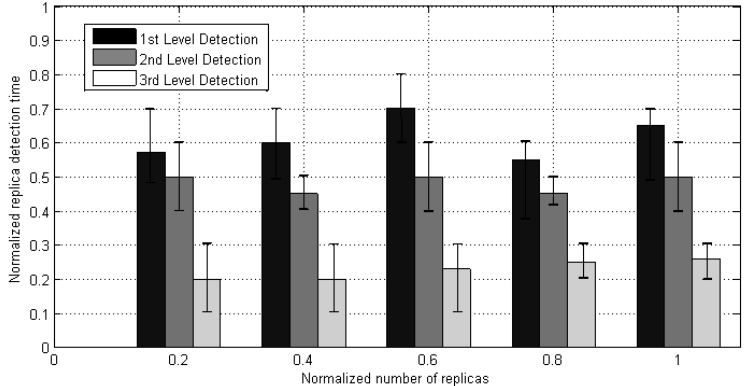
Figure 13. Detection